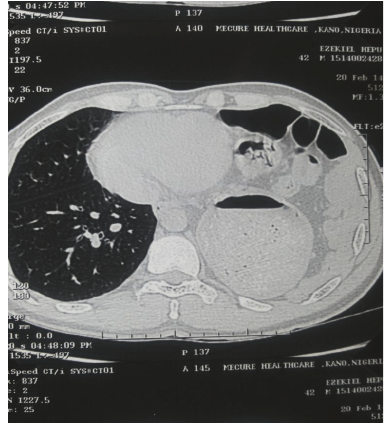
Figure 3: Computed tomography (CT) showing presence of stom- ach and bowel loops in the chest.